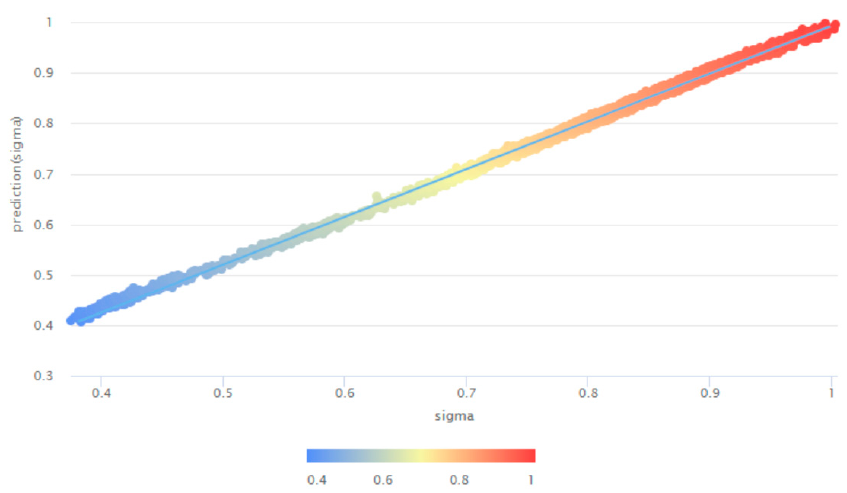
Figure 3. Prediction chart of the power dissipation P D membership values (sigma) at inverting summing amplifier design.